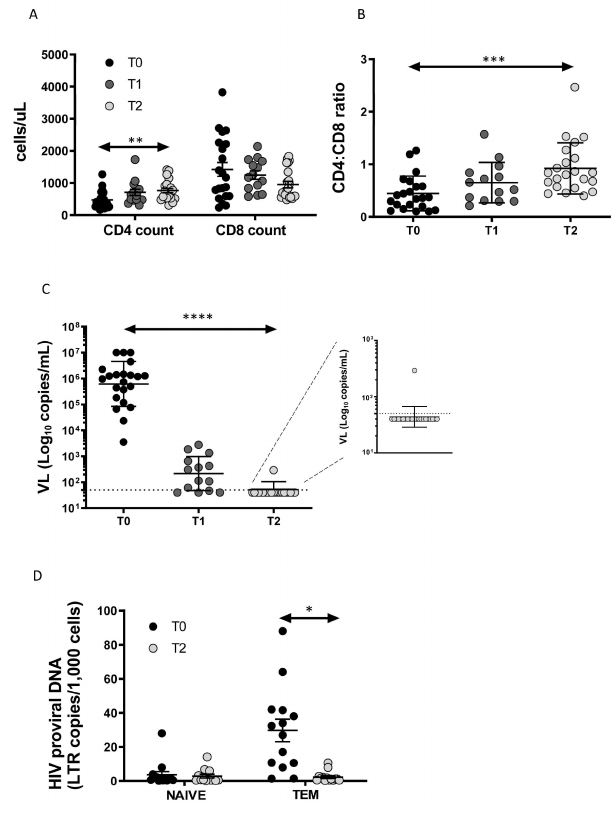
Figure 1. Immunovirological data: ( A ) CD4+ and CD8+ T-cell count at diagnosis (T0), at 2 (T1) and 12 months (T2) after the start of therapy; ( B ) CD4:CD8 ratio increases significantly after 12 months of therapy; ( C ) effective HIV treatment results in a decrease in viral load; ( D ) HIV-DNA content decreases in T EM cells. p -values are indicated by white asterisks ( ∗ p < 0.05, ∗∗ p < 0.01, ∗∗∗ p < 0.001, ∗∗∗∗ p <